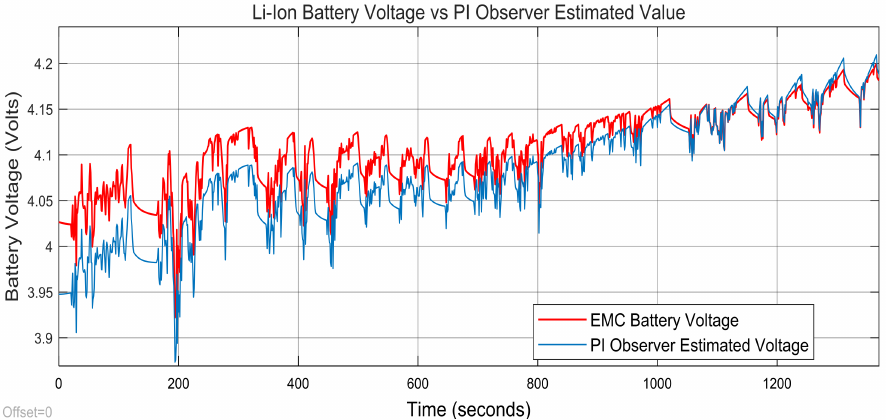
Figure 36. The 2RC EMC Li-Ion battery terminal voltage versus its PIO estimate, and the estimator robustness to a change in SOC initial value from 70 to